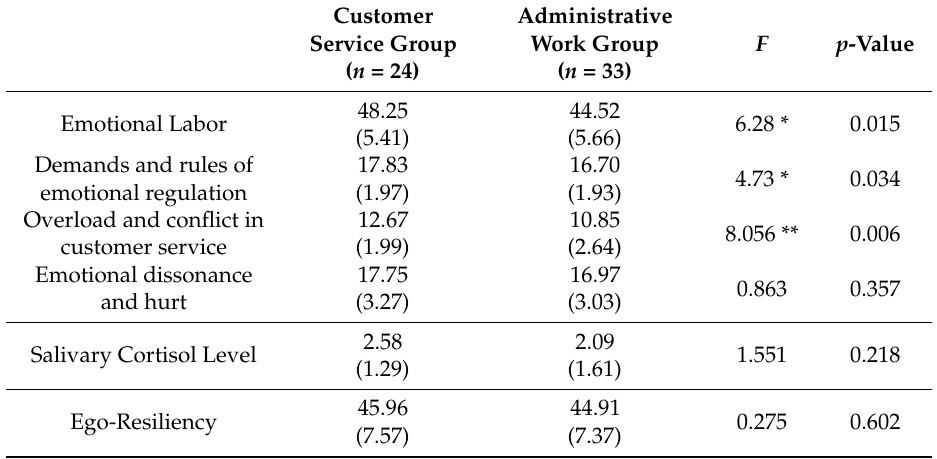
Table 2. Means (standard deviations) of the Korean Emotional Labor Scale, salivary cortisol level and ego-resiliency scale.